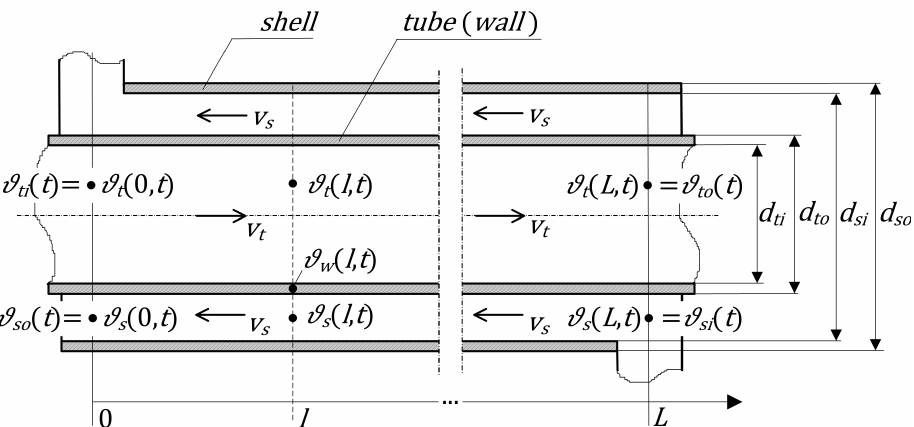
Figure 1. Double-pipe counter-flow heat exchanger: v s , v t —shell-side and tube-side fluid velocities; ϑ s , ϑ t —shell-side and tube-side fluid temperatures; ϑ w —wall temperature; ϑ si , ϑ ti — shell-side and tube-side fluid inlet temperatures; ϑ so , ϑ to —shell-side and tube-side fluid outlet temperatures; d ti , d to — inner and outer tube diameters; d si , d so —inner and outer shell diameters; L —heat exchanger